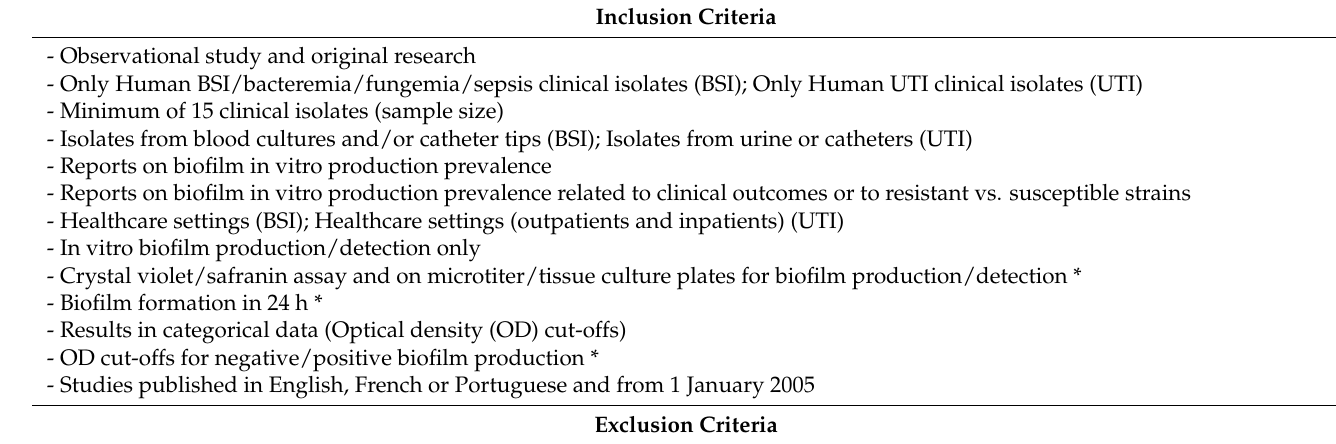
Table 1. Eligibility criteria for BSI (Bloodstream Infections) and UTI (Urinary Tract Infections). Inclusion